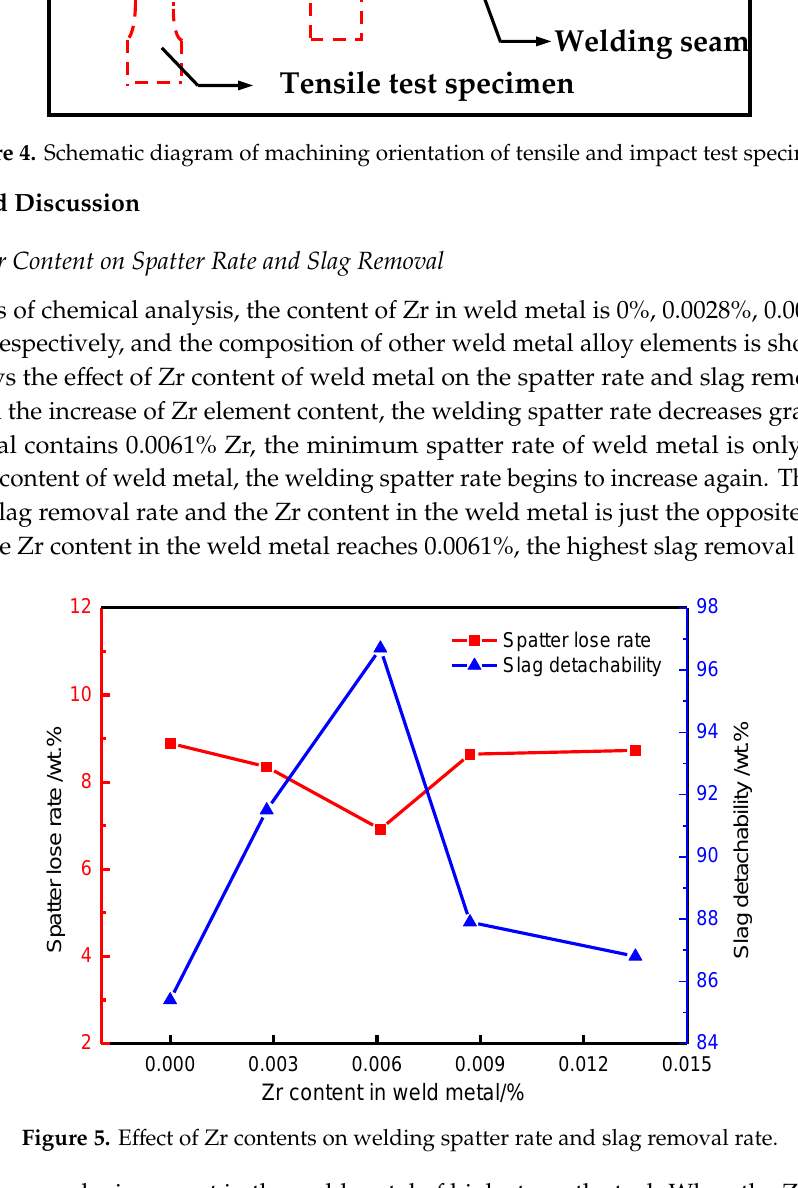
Figure 5. E ff ect of Zr contents on welding spatter rate and slag removal Figure 5. Effect of Zr contents on welding spatter rate and slag removal rate.